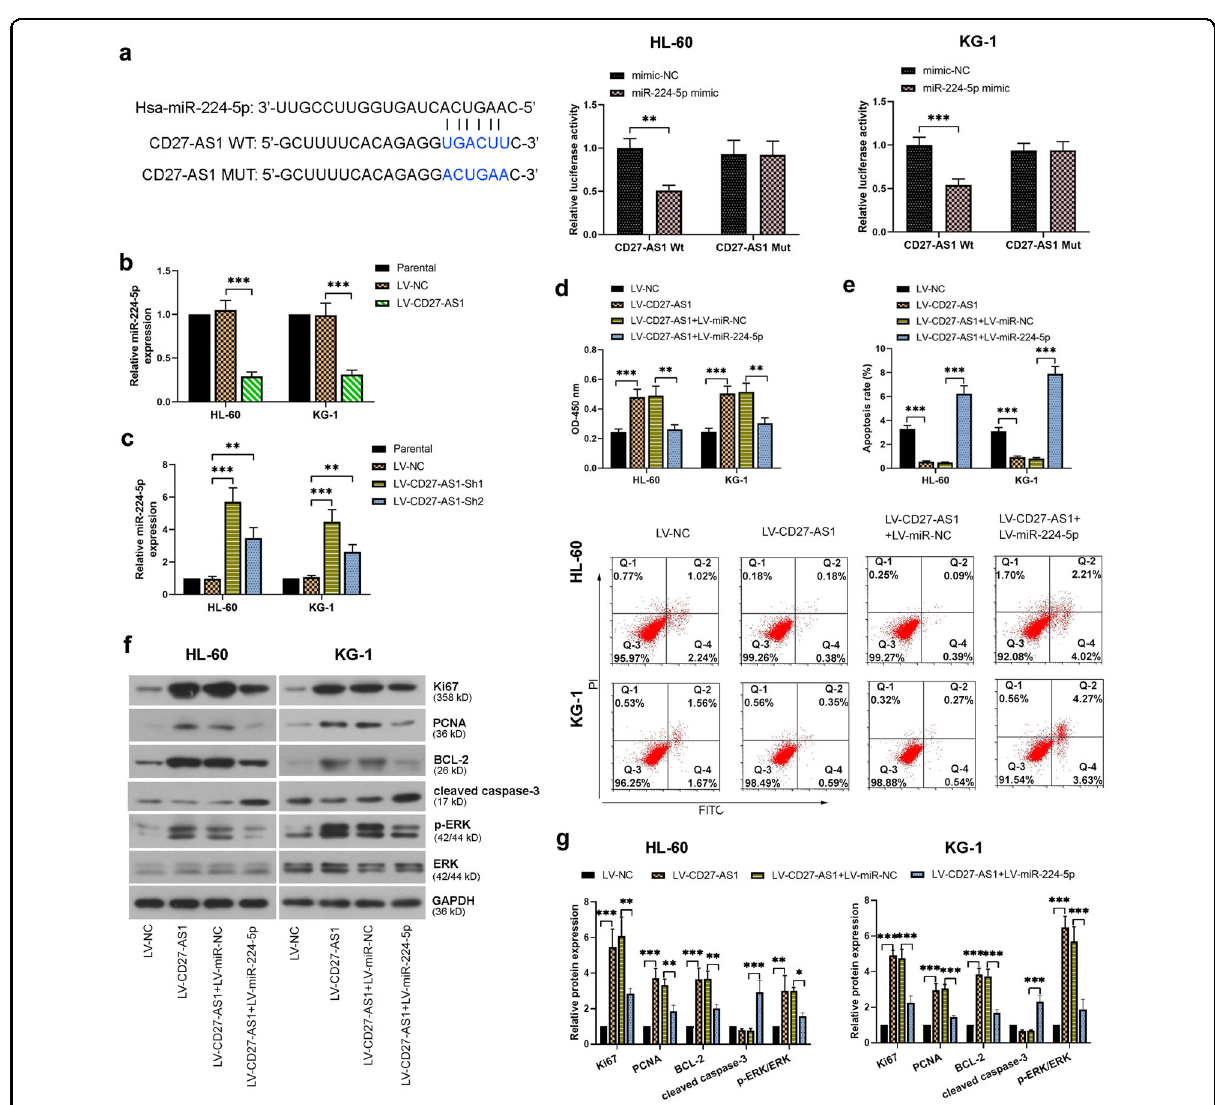
Fig. 6 CD27-AS1 regulates AML cell activity by directly targeting miR-224-5p. a Dual luciferase reporter assay was carried out to verify the binding effects of miR-224-5p on CD27-AS1. Potential binding sequences between them were predicted from Starbase database. b , c Relative miR- 224-5p expression was assessed in HL-60 and KG-1 cells with CD27-AS1 overexpression and CD27-AS1 knockdown, respectively, using qRT-PCR. Two AML cells were co-infected with the LV-CD27-AS1 and LV-miR-224-5p. d Cell viability and ( e ) cell apoptosis were then detected using CCK-8 assay and fl ow cytometry, respectively. f Western blotting was performed to check protein levels of Ki67, PCNA, BCL-2, cleaved caspase-3, ERK, and p-ERK in the AML cells after co-infection. g Quanti fi cation of above protein expression from western blotting. N = 3. Data were shown as means ± SD. * P < 0.05, ** P < 0.01, and *** P <